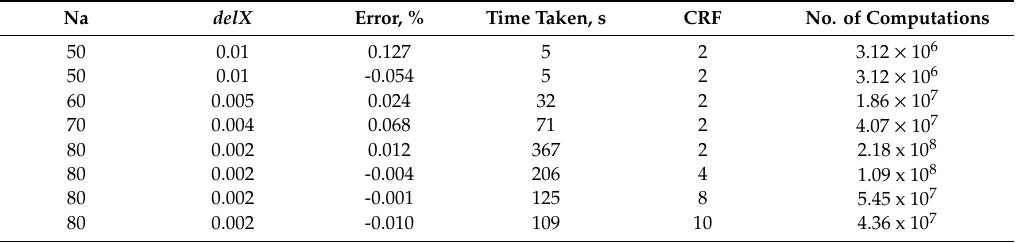
‘* Refer to Figure 4c. Dimensions: a = 0.5, b = 0.3, c = 0.6, Φ = 90 ◦ , analytic result F 1-2 =